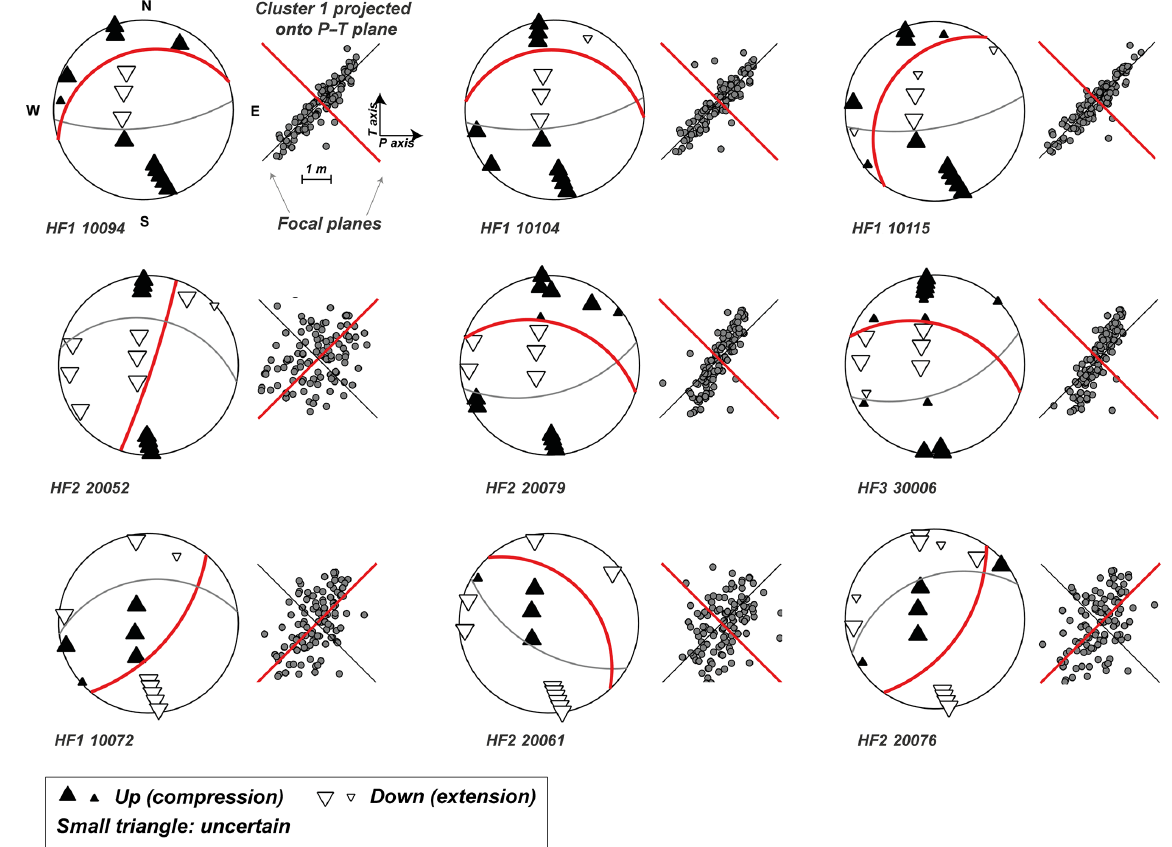
Figure 11. Stereographic plots of focal plane solutions. Next to each focal mechanism is the projection of the seismicity cloud of the corresponding hydrofracture onto a plane defined by the P and the T axis where the focal planes appear as a diagonal cross. If the seismicity cloud orientation agrees with one of the focal planes, the seismic events group closely around one of the planes. Note that the focal plane on which stress was resolved in Fig. 14 is marked as a red